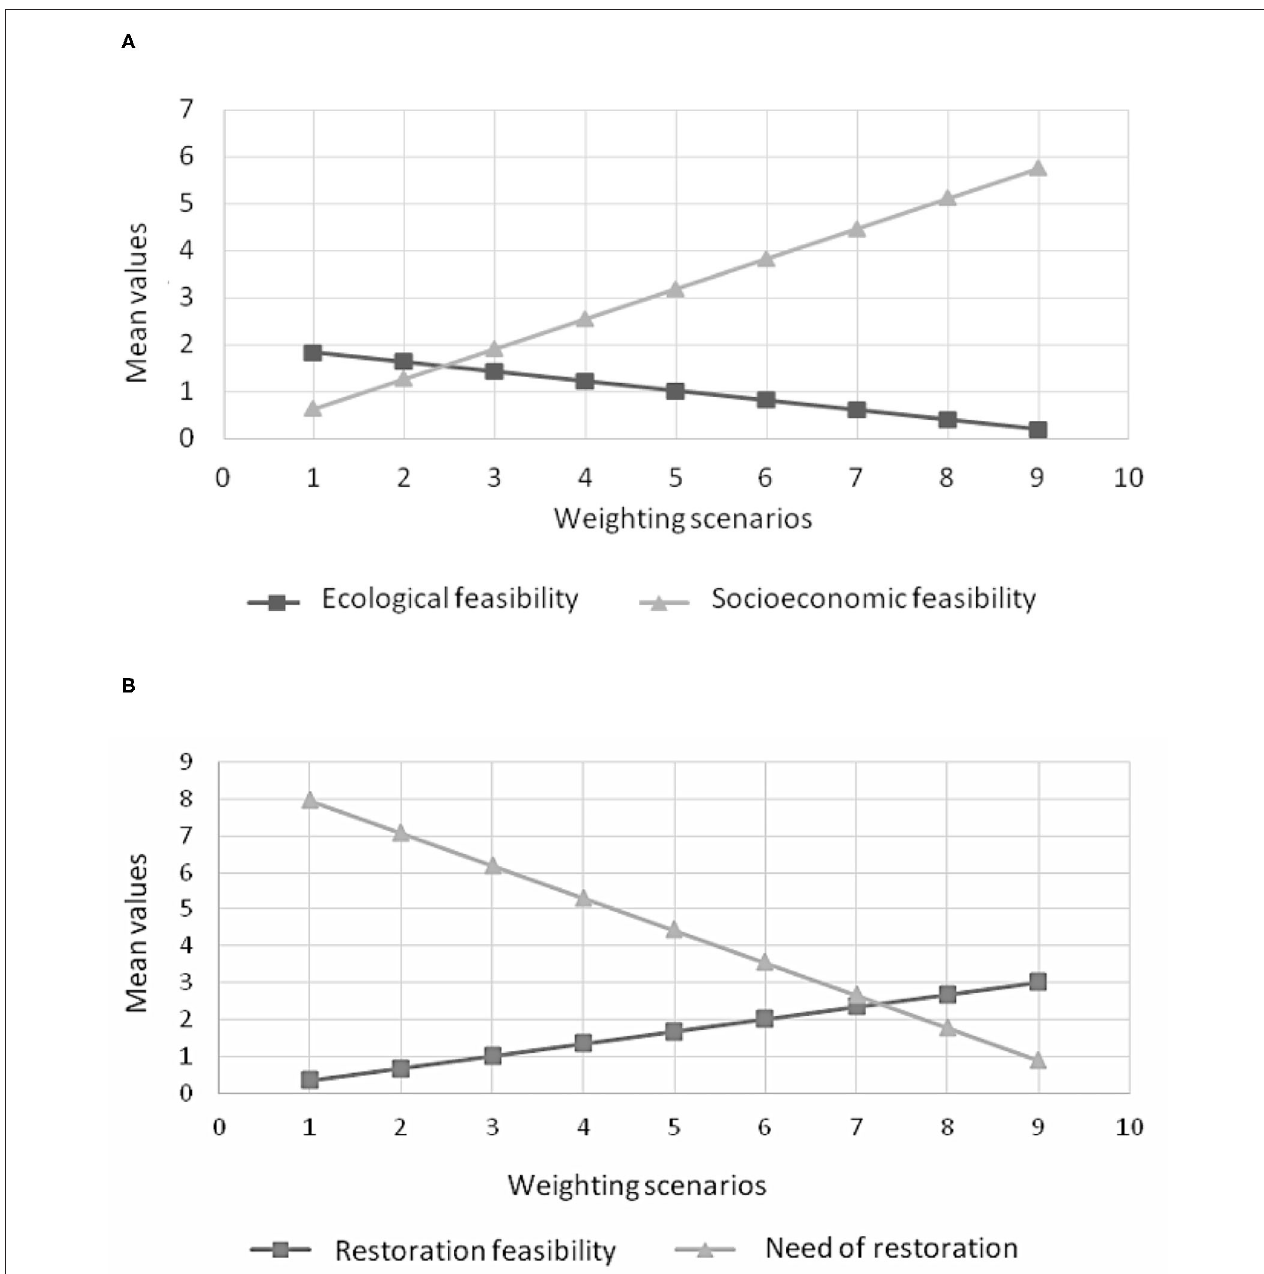
FIGURE 2 | Graphs representing the mean values of the two factors of the multicriteria analysis and two types of restoration feasibility along different weighting scenarios. Graph for ecological and socioeconomic feasibility (A) ; graph for need and feasibility of restoration (B) . Weighting scenario 1 starts with a weight of 0.1 and 0.9 to each variable respectively and scenario 9 correspond to a weight of 0.9 and 0.1 for the variables. In each scenario weights vary by 0.1